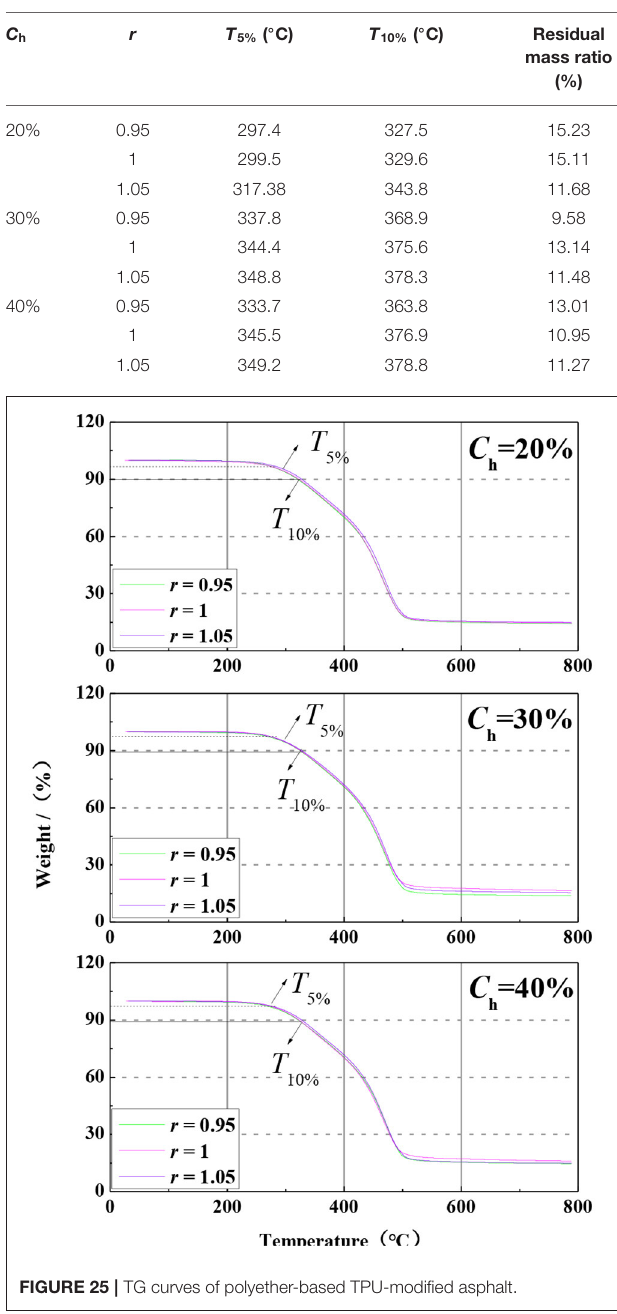
asphalt, which is roughly the same as the temperature scanning test